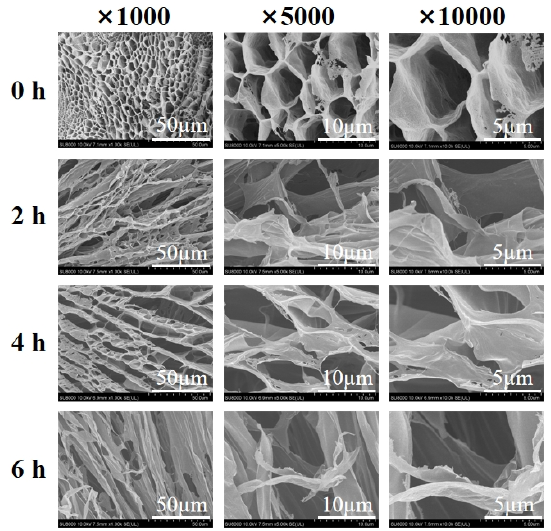
Figure 10. Cryo-SEM images of the samples of κ -carrageenan, DC-2, DC-4, and DC-6. (Magnifications: × 1000, × 5000, and × 10,000).